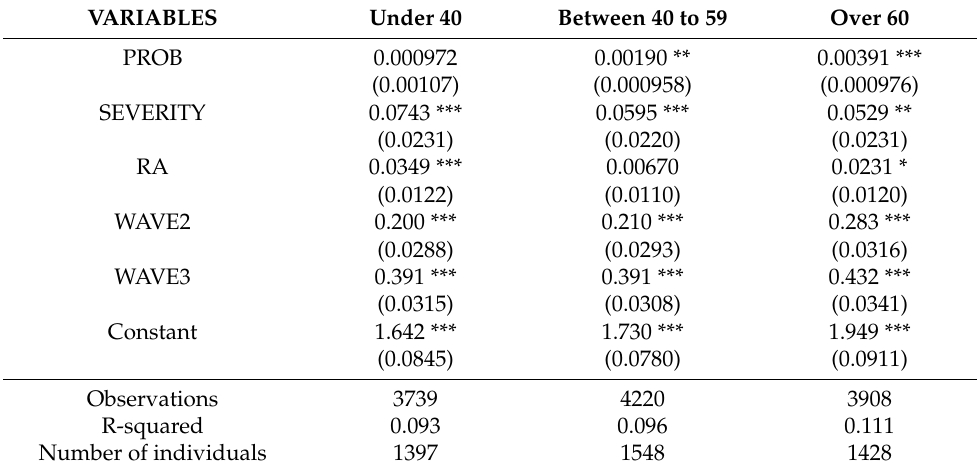
Table 8. Estimation results by age group.